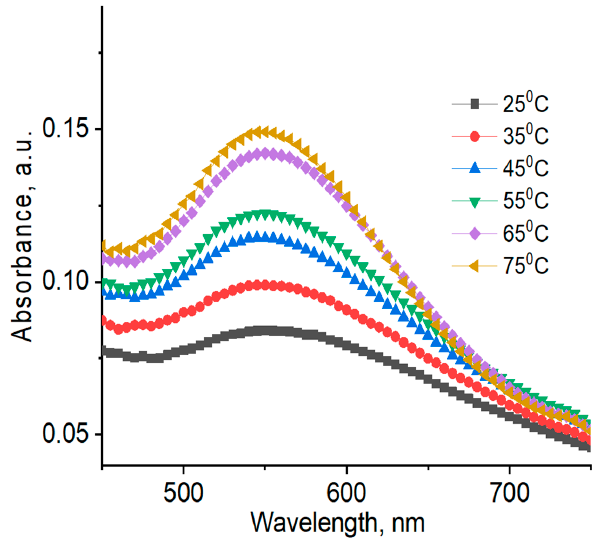
Figure 12. UV – Vis spectra of AuNPs synthesized and stabilized using 4 wt % PVP 40 kDa at different temperatures. [HAuCl 4 ] = 0.01 mM.